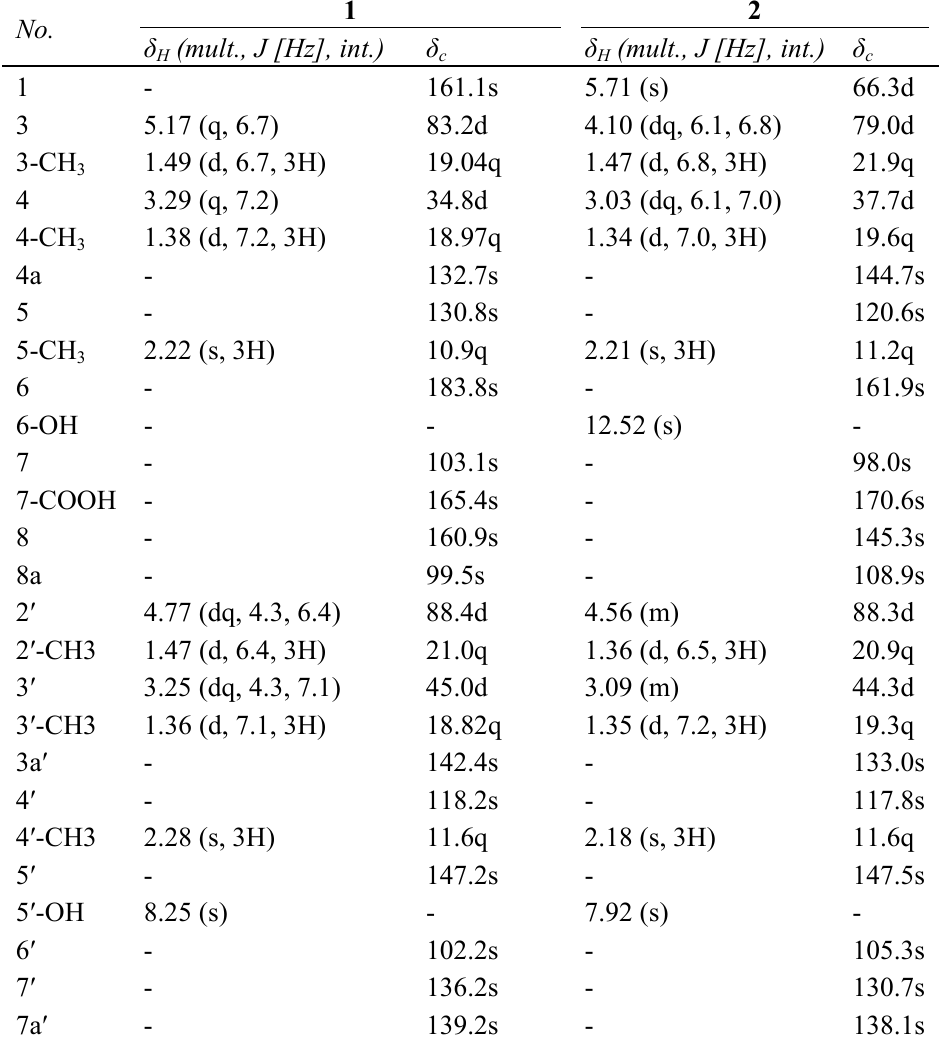
Table 1. 1 H- and 13 C-NMR (600 and 150 MHz) data for compounds 1 and 2 (CDCl